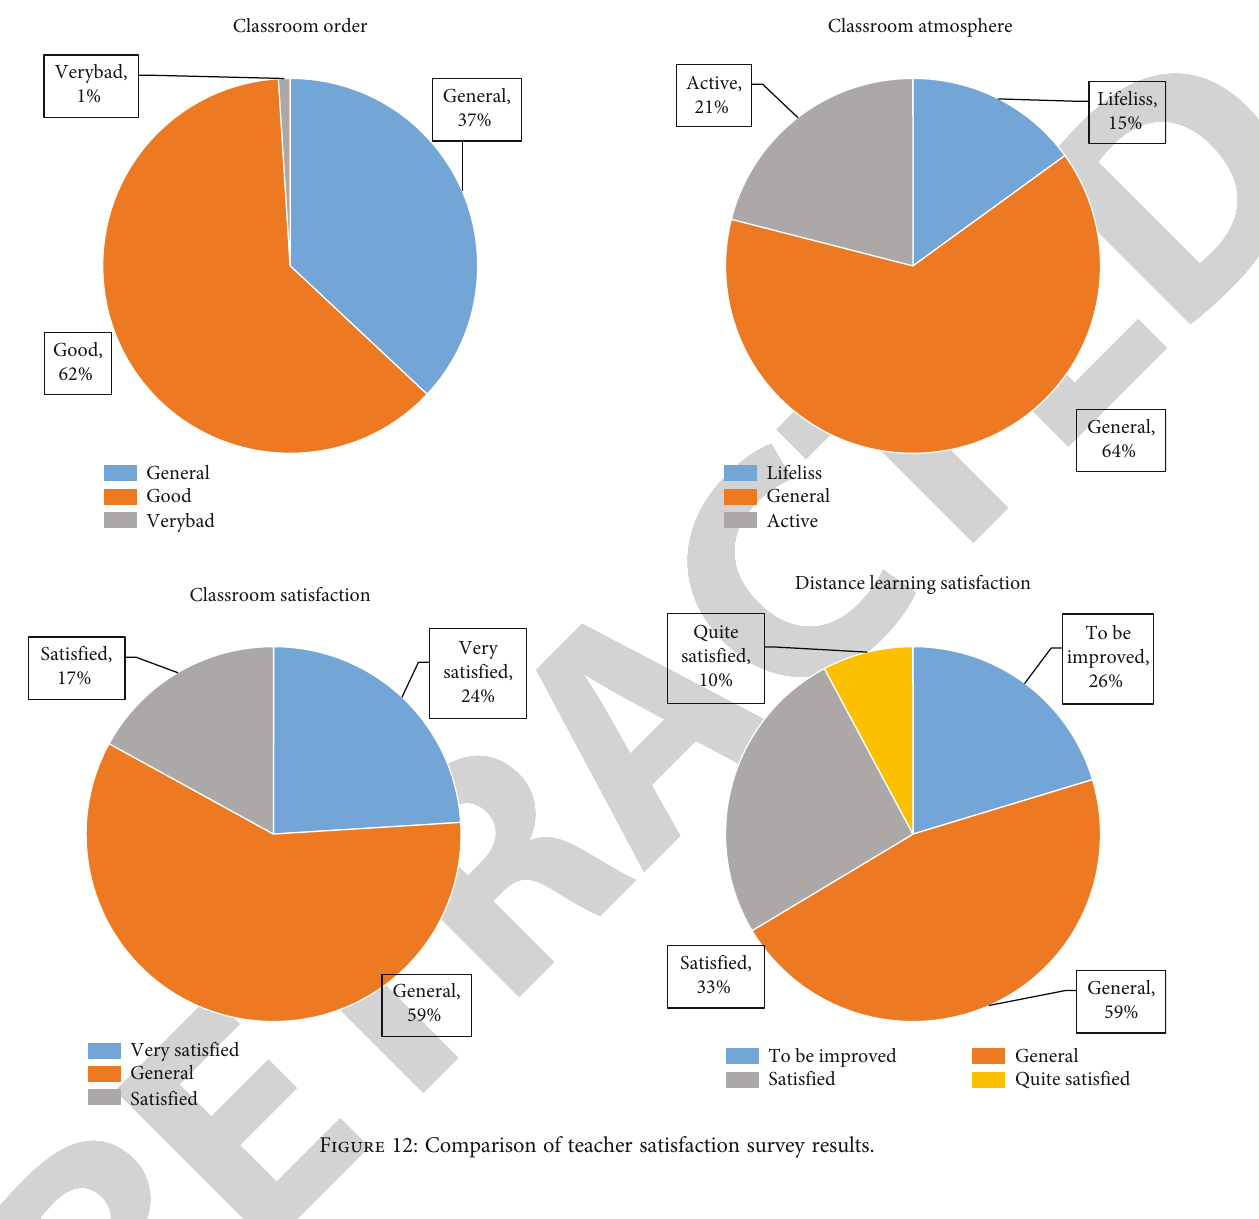
Figure 12: Comparison of teacher satisfaction survey